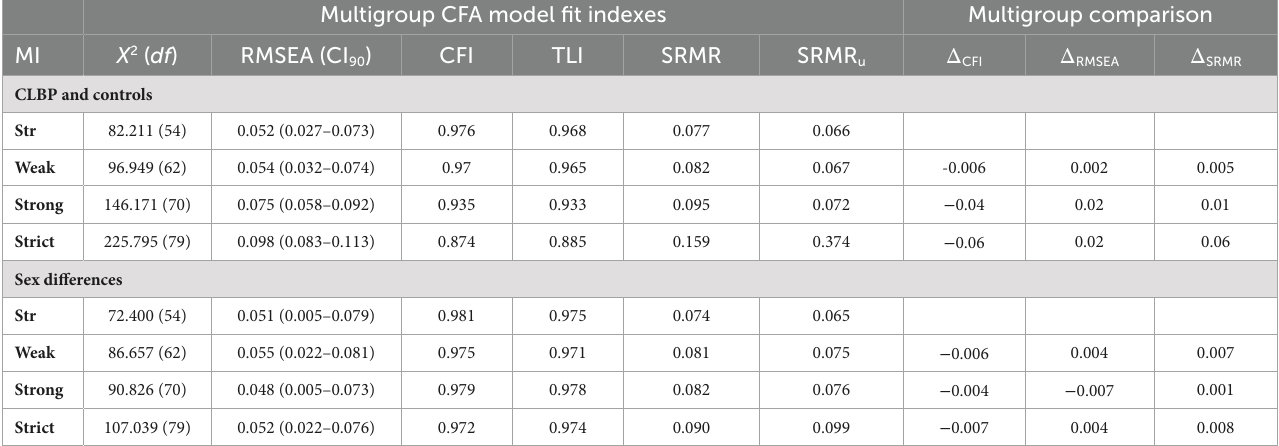
TABLE 3 Multigroup confirmatory factor analysis model fit indexes and multigroup